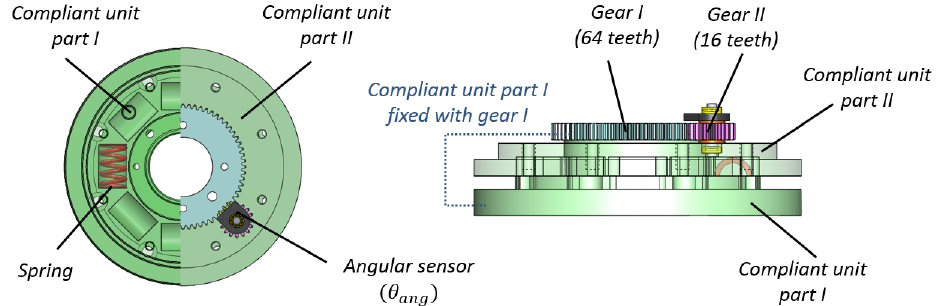
Figure 5. Mechanical design of a hollow compliant unit.